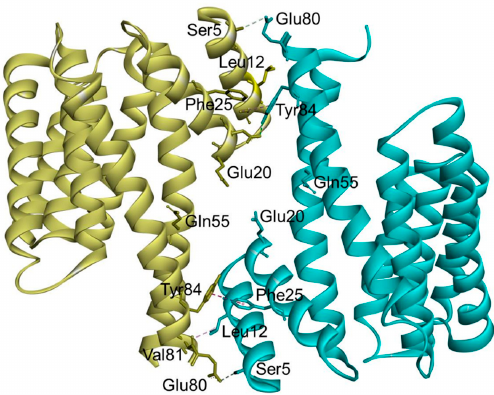
Figure 3. Ribbon representation of the human 14-3-3 σ homodimer (PDB: 1YWT). The residues involved in the stabilization of the homodimer molecule and maintaining the full dimerization activity of 14-3-3 σ are labeled, with hydrogen bond interactions (cyan dashed line) and hydrophobic interactions (purple dashed line).